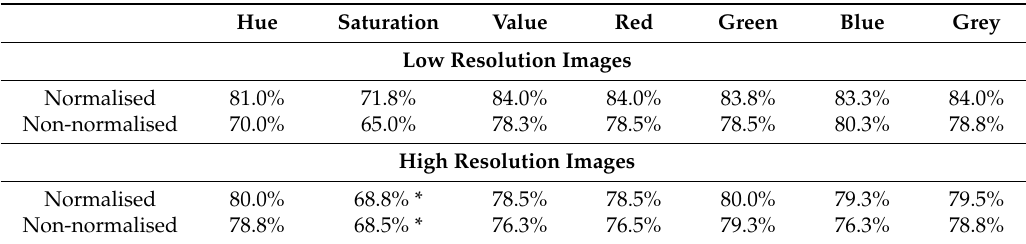
Table 2. The accuracy ACC of binary separation of cross-sections.